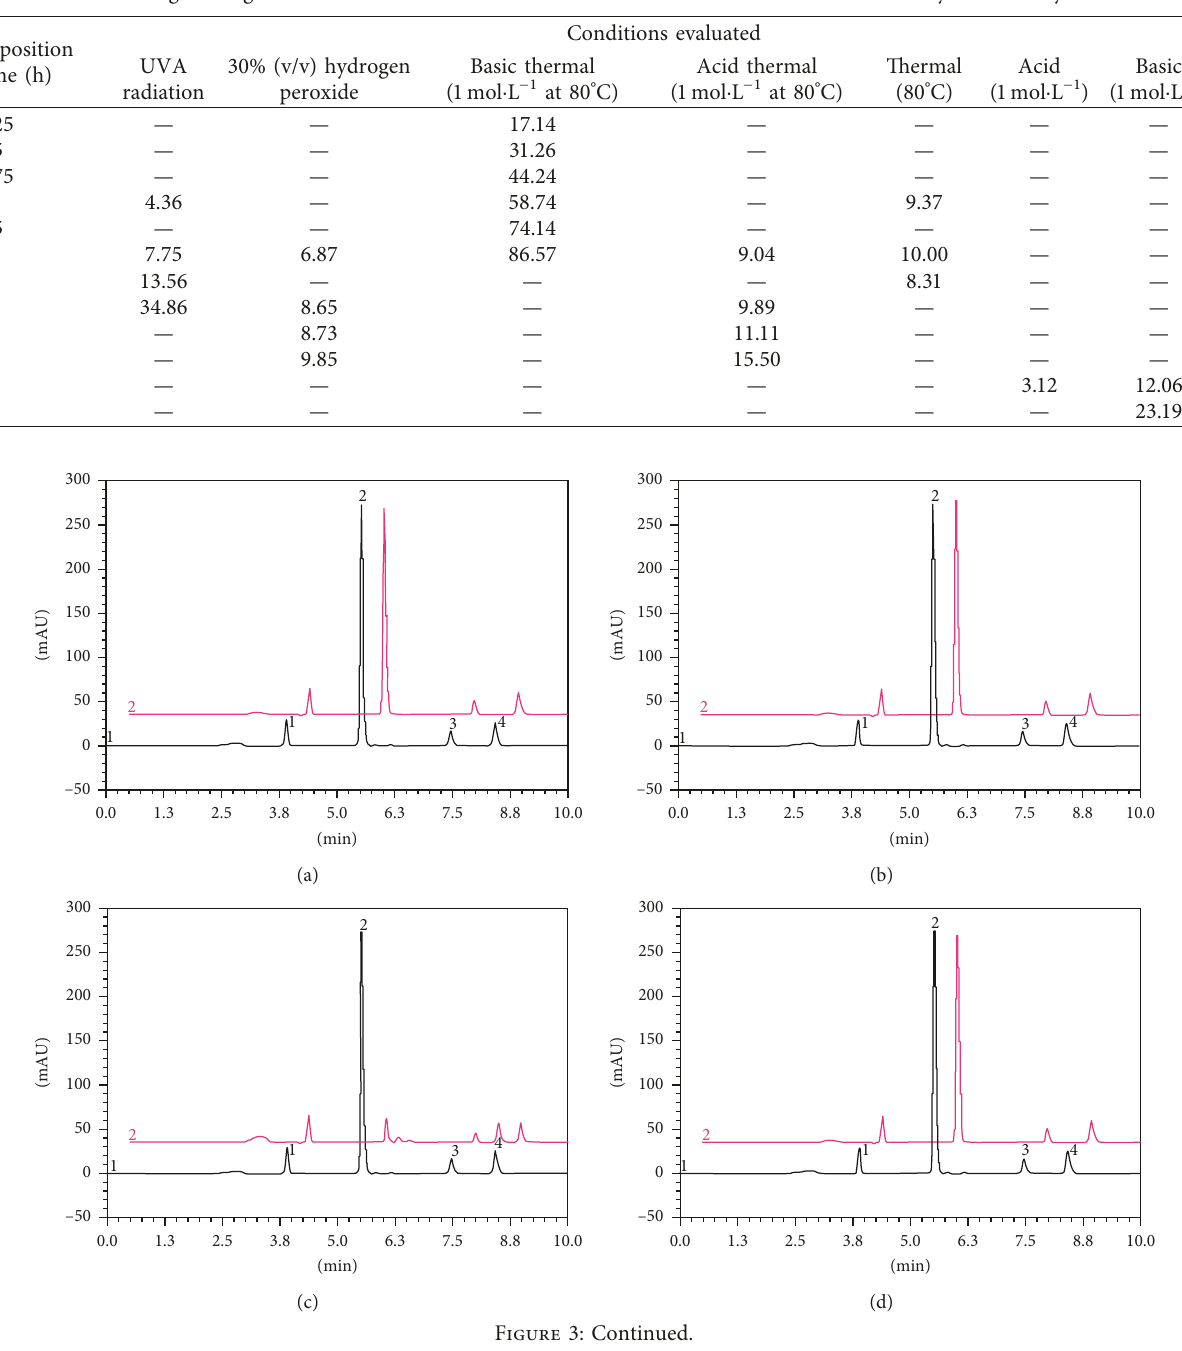
Table 2: Percentage of degradation of LGT under different stress conditions to evaluate the selectivity of the analytical method. Exposition